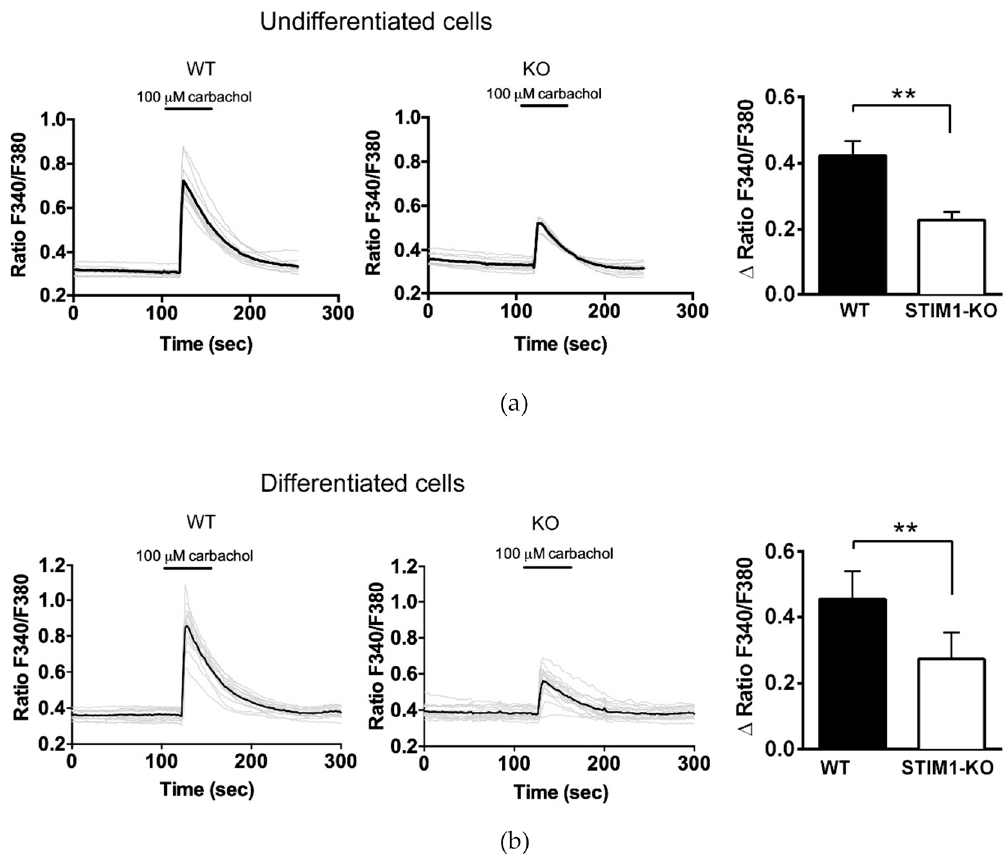
Figure 2. Decrease of carbachol-evoked Ca 2 + release in STIM1-deficient cells. Undi ff erentiated cells ( a ) or di ff erentiated cells ( b ) were loaded with fura-2 to measure Ca 2 + kinetics in response to a 30 s pulse of 100 µ M carbachol (CCh) in Ca 2 + -free medium. After CCh addition, cells were washed out 3 times with Ca 2 + -free Hank’s balanced salt solution (HBSS). The increase of the ratio F340 / F380 induced by CCh was quantified from a minimum of 40 cells and 4 independent experiments (n = 68 undi ff erentiated WT cells, n = 58 undi ff erentiated KO cells, n = 53 di ff erentiated WT cells, n = 40 di ff erentiated KO cells). The results are shown in the bar chart as mean ± S.D. (**) Statistical significance p < 0.01.